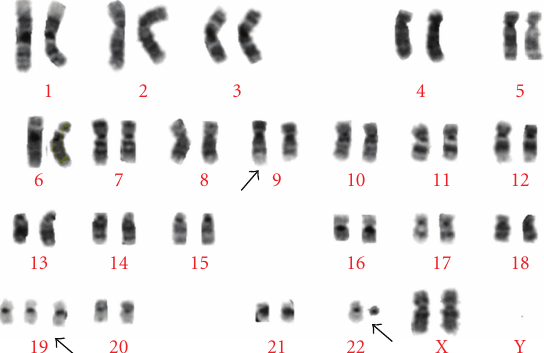
Figure 1: G-Banded karyotype of one of the leukemic clones showing 47, XY,+19, +t(9;22)(q34;q11); arrows indicate the structurally and numerical abnormal